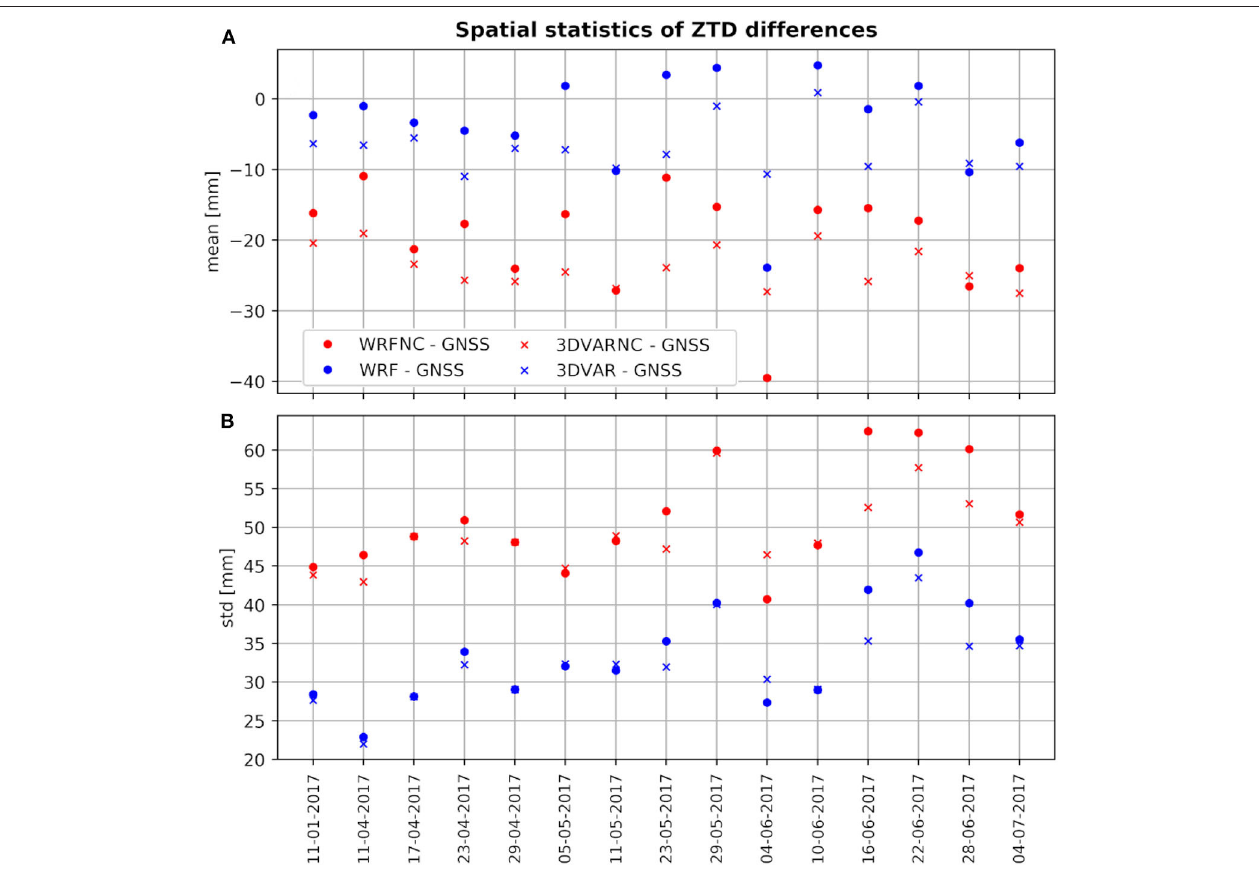
FIGURE 9 | Spatial statistics of the ZTD differences with respect to the GNSS ZTD. The time series of the mean value are shown in (A) and the time series of the standard deviation are shown in (B) . “WRFNC” indicates the model outputs with no data assimilation and no height correction; “WRF” are the outputs of WRF corrected for the height difference with the InSAR data; “3DVARNC” shows the model output after assimilating the GNSS with no height discrepancy correction; “3DVAR” denotes the time series of the 3DVAR output corrected for the height